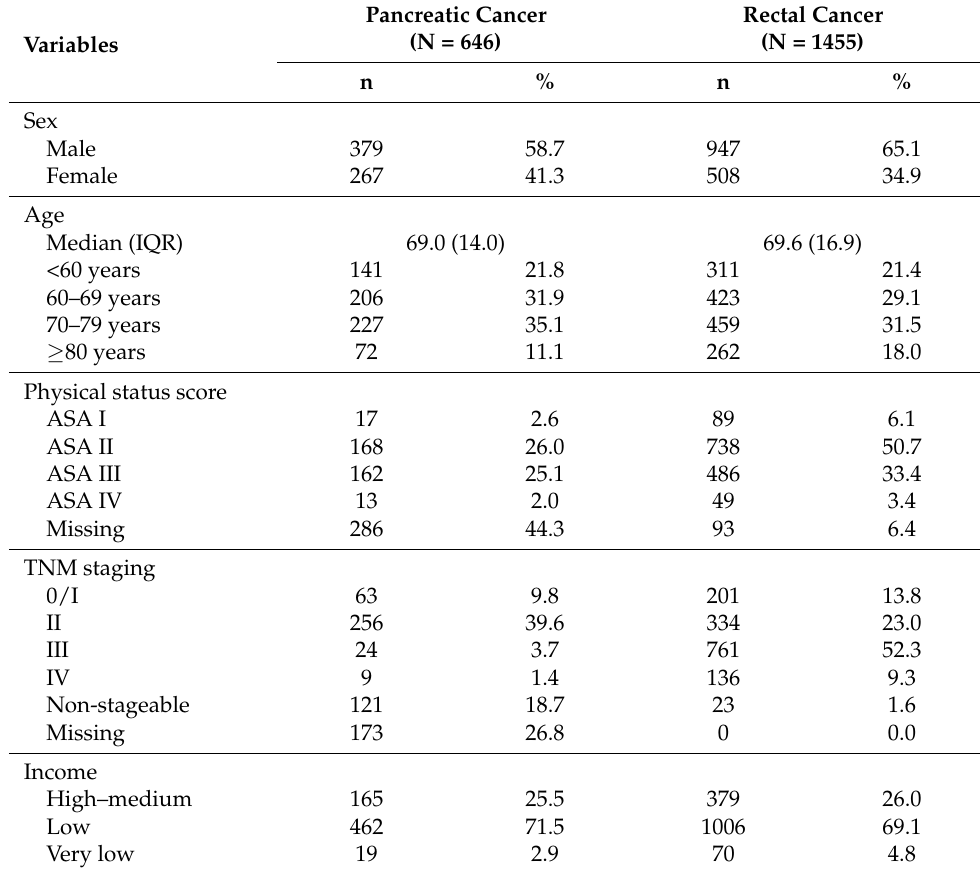
Table 1. Baseline characteristics of cohort by type of cancer.